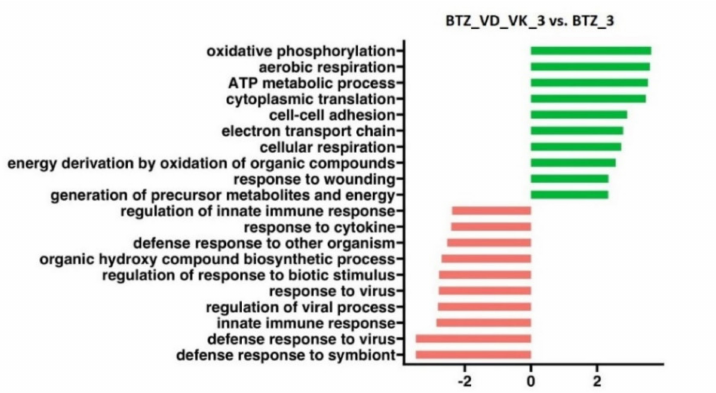
Figure 10. GSEA performed in U266 cells after BTZ and vitamin administration (BTZ_VD_VK_1—first treatment; BTZ_VD_VK_2—second treatment; BTZ_VD_VK_3—third treatment). Plots show normal- ized enrichment scores (NES) for the most positively and negatively enriched gene sets. The green color shows activation of selected processes, and the red color shows inhibition. p <